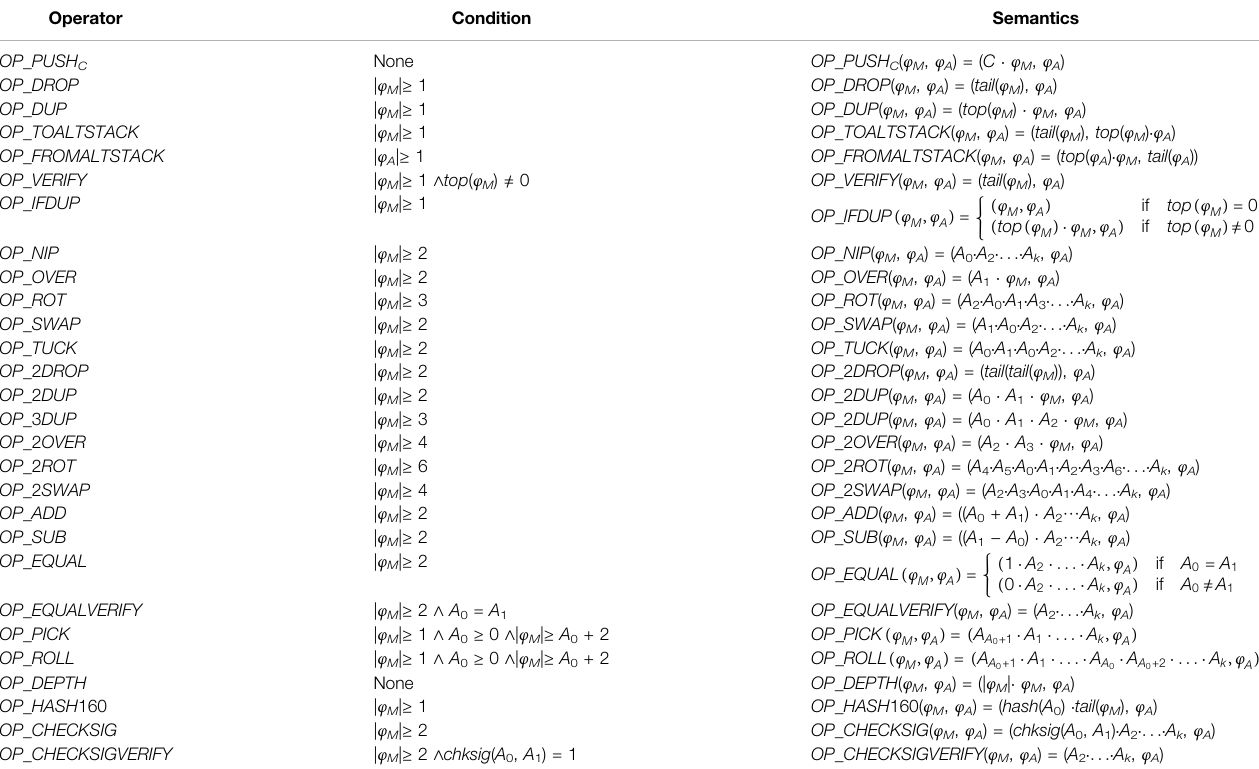
TABLE 1| SemanticsofScriptcommands. Weassume that φ operator not to return an error. Formally, if the condition for operator f is not met by ( φ M , φ A ), then f ( φ M , φ A ) (cid:1) □ . The function hash corresponds to using SHA-256 and RIPEMD-160 hashing algorithms in succession. The function chksig corresponds to the veri fi cation algorithm of the ECDSA protocol for the string comprised of the transactioninformation,the fi rstinputasthepublickeyandthesecondinputasthesignature.Computingthetransaction informationisanon-trivialprocessinBitcoin. Since the main focus in this paper is to study the properties of Script itself, we do not model this process in our formalization.